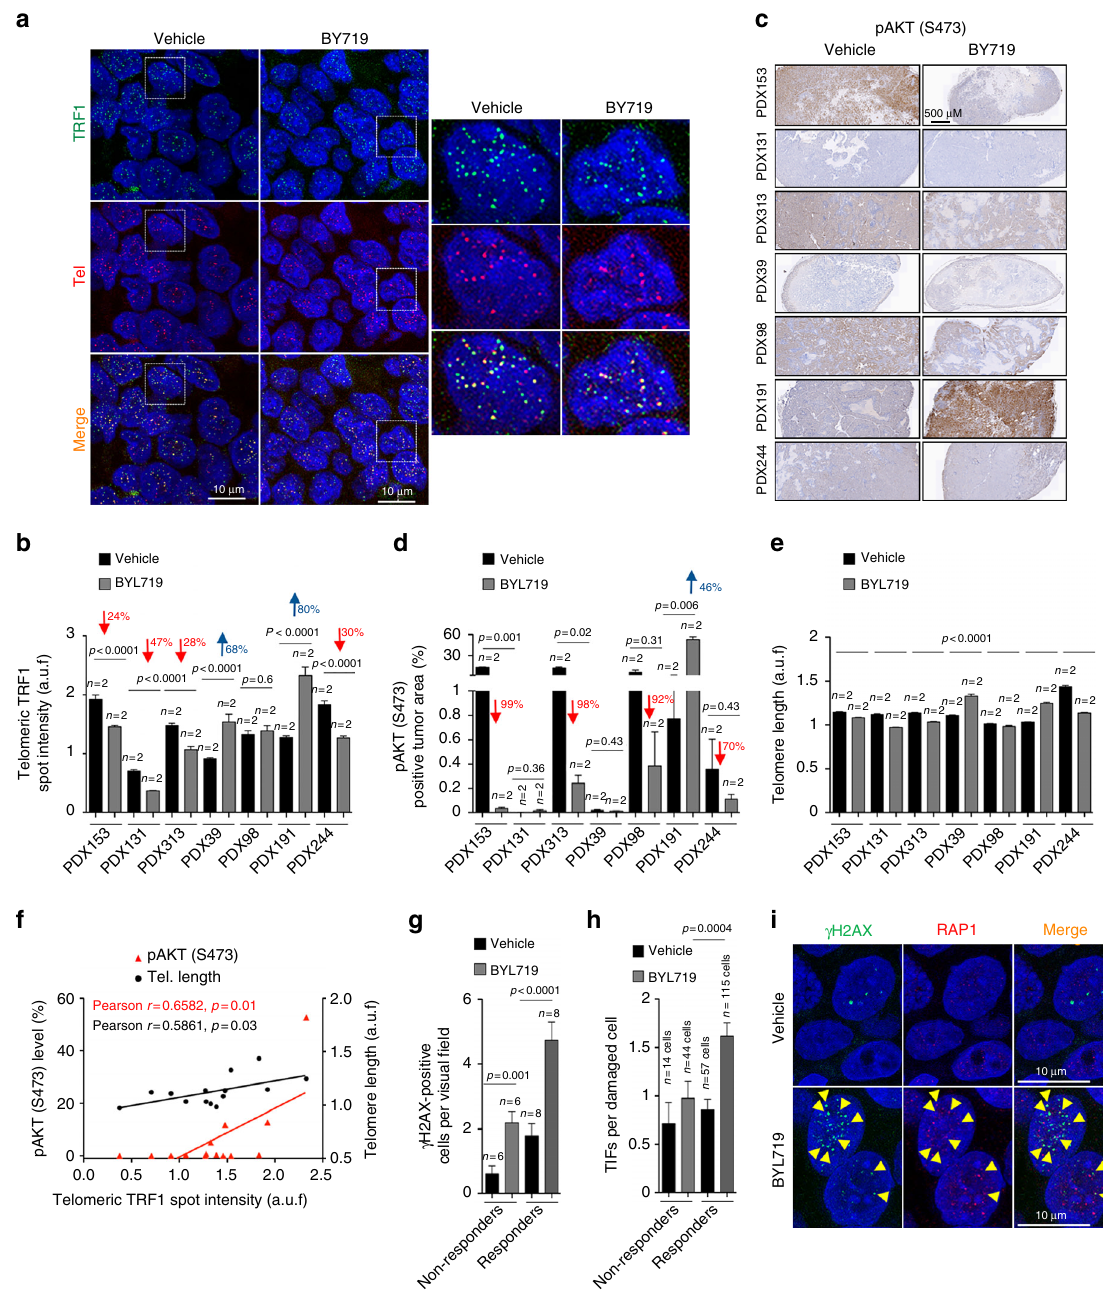
Fig. 8 Inhibition of PI3K α decreases TRF1 levels and increases telomeric DNA damage in human PDXs. a Representative immunoFish images of TRF1 immuno fl uorescence and telomeric DNA FISH of vehicle and BYL719-treated PDXs. Seven independent tumors were used to generate PDXs in duplicate per condition. Scale bars are shown. b Quanti fi cation of telomeric TRF1 foci intensity by immuno fl uorescence in seven independent PDXs treated either with vehicle or with BYL719 for 12 days. Telomeric TRF1 foci were identi fi ed by colocalization with telomeric DNA by FISH. The percent change in telomeric TRF1 intensity in treated PDXs as compared to non-treated are indicated in each case. Seven independent tumors were used to generate PDXs in duplicate per condition. c Representative immunohistochemistry images of phosphorylated AKT (S473) in PDXs treated with either vehicle or with BYL719. Scale bars are shown. d Quanti fi cation of pAKT (S473) positive area with regards to total tumoral area in each PDX. Scale bars are shown. The ef fi cacy of the treatment was analyzed by quantifying the percent inhibition of pAKT (S473) as compared to vehicle treated controls and is indicated in each case. e Quanti fi cation of mean telomere length by Q-Fish in PDXs treated either with vehicle or with BYL719 for 12 days. f Pearson correlation analysis between telomeric TRF1 foci intensity and pAKT or mean telomere length of untreated and BYL179 treated PDXs. The Pearson r coef fi cient and the P values are indicated. g , h Number of positive γ H2AX cells ( ≥ 3 foci) ( g ) and quanti fi cation of telomere-induced foci (TIFs) by double immuno fl uorescence with anti- RAP1 and anti- γ H2AX antibodies ( h ) in PDXs treated either with vehicle or with BYL719 for 12 days. The PDXs were grouped in non-responders or responders according to the ef fi cacy of BYL179 treatment as measured in d . i Representative RAP1 and γ H2AX immuno fl uorescence images of vehicle and BYL719-treated PDXs. Damage cells (green) are marked with a white arrow and TIFs (yellow) with a yellow arrow head. Scale bars are shown. Student ’ s t test was used for statistical analysis and P values are shown. Error bars represent standard errors. n number of independent